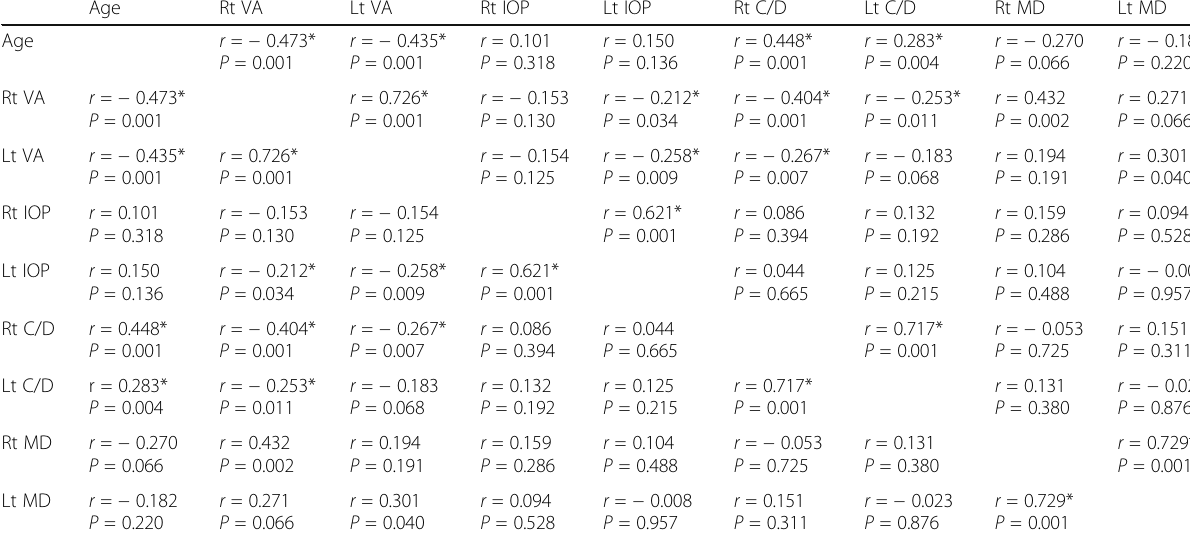
Table 3 Correlations between clinical parameters among all studied